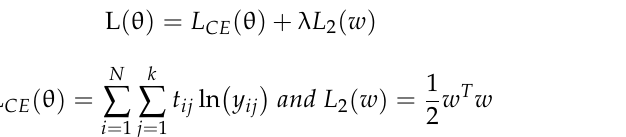
To train the U-Net from the given datasets, a stochastic gradient descent with mo- mentum (SGDM) optimizer [52] was used with different training options: 10, 25, and 50 mini-batches, and 10, 25, and 50 epochs. All batches were normalized. Datasets were shuf- fled at every epoch during training, and the learning rate and hyperparameter of L2 reg- ularization were set to 0.05 and 0.0001, respectively.